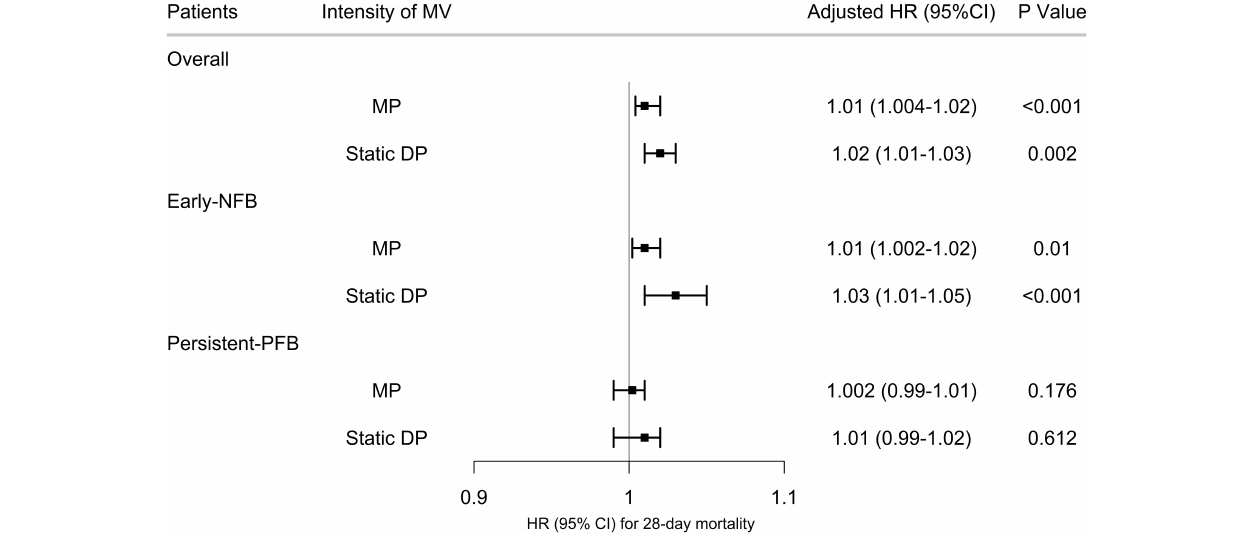
FIGURE 3 | Association between time-varying intensity of mechanical ventilation and 28-day mortality. The hazard ratio and 95% confidence intervals (error bars) in both cohorts were adjusted for the selected covariates. Early NFB, Early Negative fluid balance; Persistent-PFB, Persistent-Positive fluid balance; MV, Mechanical Ventilation; HR, hazard ratio; CI, confidence